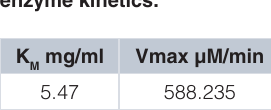
Table 2. K and Vmax from M enzyme kinetics.